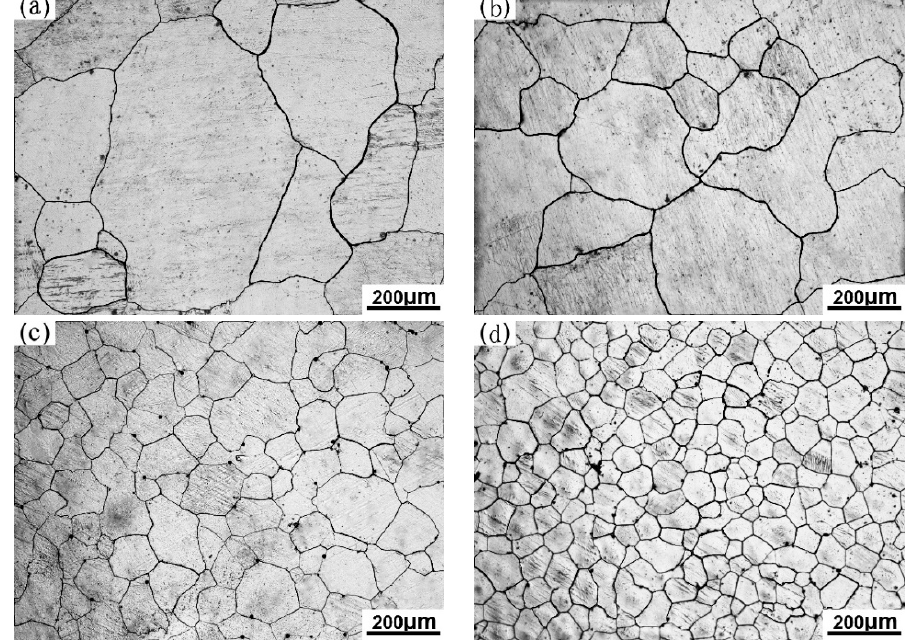
Figure 1. Grain morphologies of ( a ) the original Mg-3%Al alloy, ( b ) the Mg-3%Al alloy containing 0.05%Fe, ( c ) the Mg-3%Al alloy containing 0.05%Fe refined by carbon inoculation, and ( d ) the Mg-3%Al alloy containing 0.05%Fe refined by carbon inoculation, combined with 0.2%Ca.